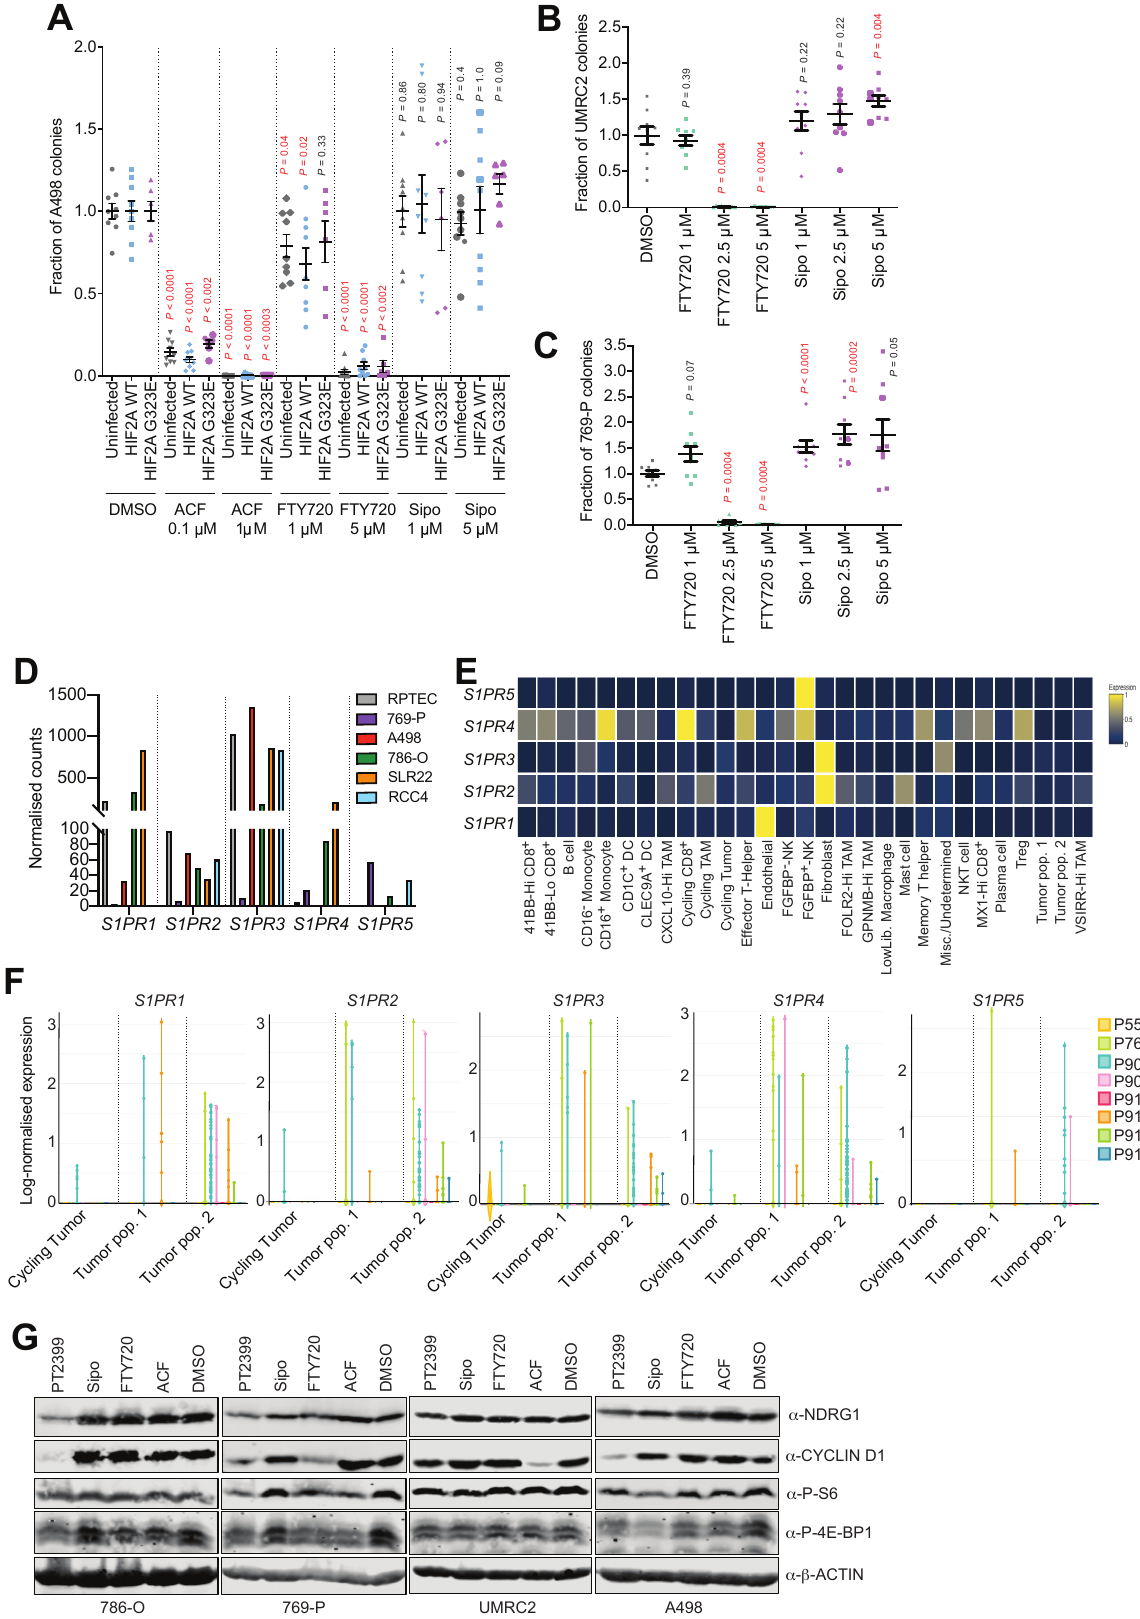
Figure 5. Multiple S1P receptors contribute to ccRCC tumor cell proliferation. ( A – C ) Quantifications of colony formation, expressed as the fraction of colonies formed in cultures of A498, HIF2A WT, HIF2A G323E, UMRC-2, and 769-P cells